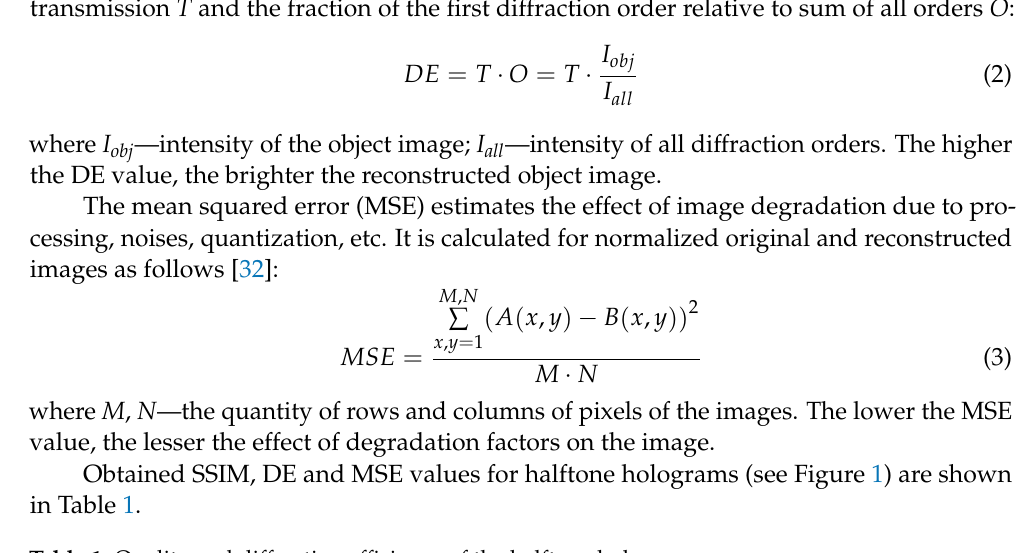
Table 1. Quality and diffraction efficiency of the halftone holograms. Object Baboon House Tree